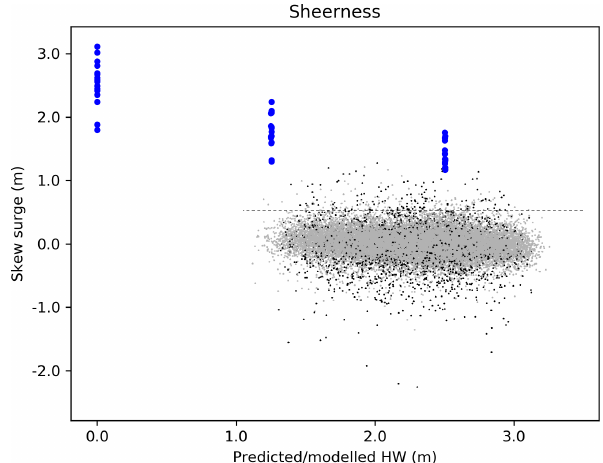
Figure E2. Our skew surge and tide interaction results for Sheerness overlain on a reproduction of Williams et al. (2016), their Fig. S2. The results for a modelled high water of zero are included for com- parison. They come from a very artificial simulation in which no tidal forcing is included. In reality, of course, the tide is always